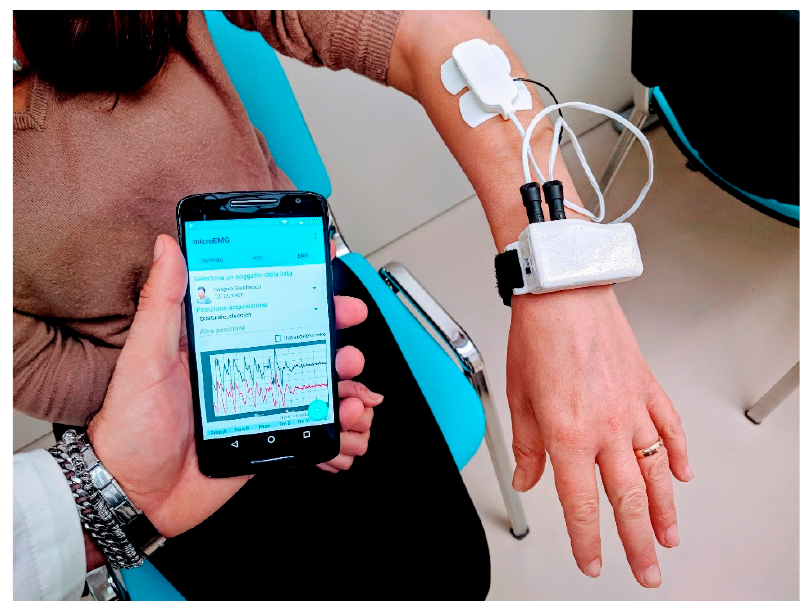
Figure 2. µEMG experimental system: wearable device and mobile app. Figure 2. µ EMG experimental system: wearable device and mobile